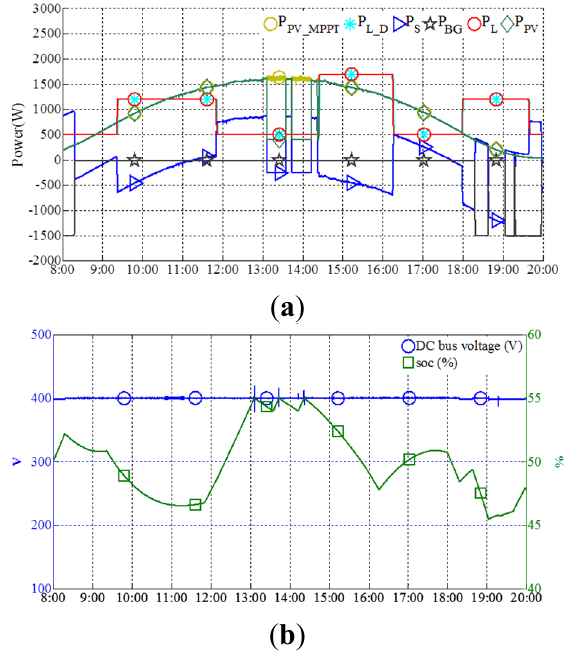
Figure 9. ( a ) Experimental real-time power flow for Test 1; ( b ) Experimental DC bus voltage and soc evolution for Test